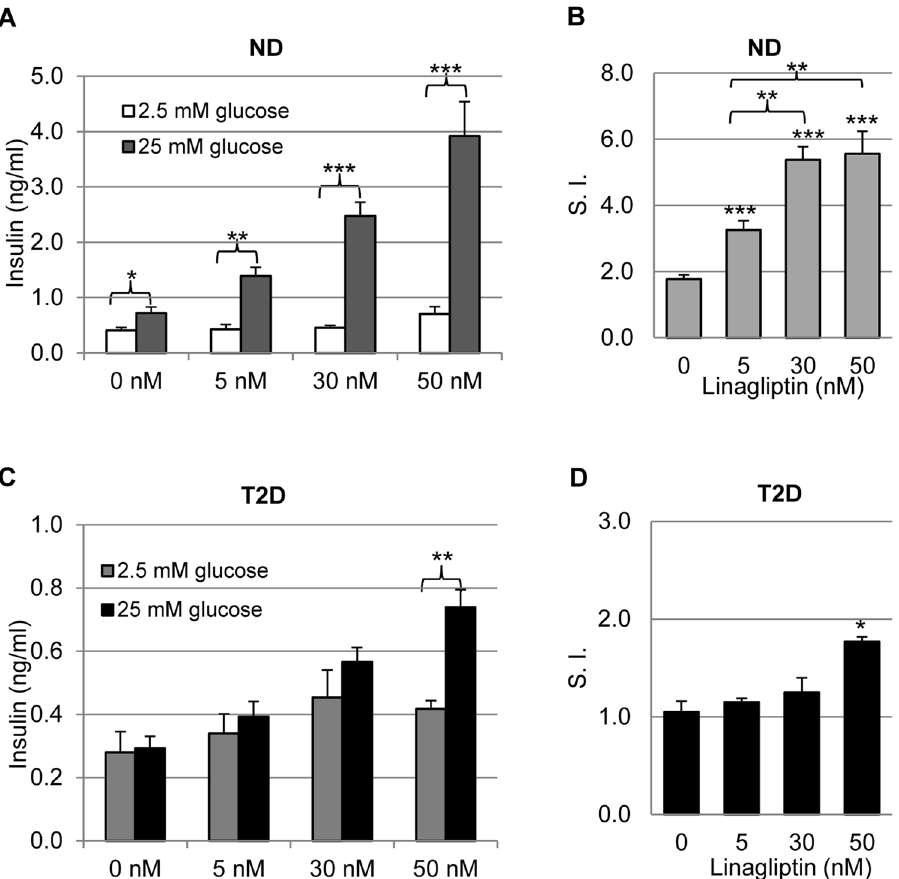
Figure 3. Glucose-stimulated insulin secretion in response to linagliptin treatment. ND ( A ) and T2D ( C ) human islets were subjected to GSIS tests using 2.5 mM as low glucose and 25 mM as high glucose conditions, in the presence of 0, 5, 30, and 50 nM linagliptin. All data were normalized with the total islet lysate proteins (per ug protein), and expressed as Mean ± SEM. The stimulation index (S. I.) was calculated by dividing the insulin concentration at high glucose by that at low glucose for each group ( B , D ). * p < 0.05; ** p < 0.01; and *** p < 0.001 (compared to untreated group unless indicated).